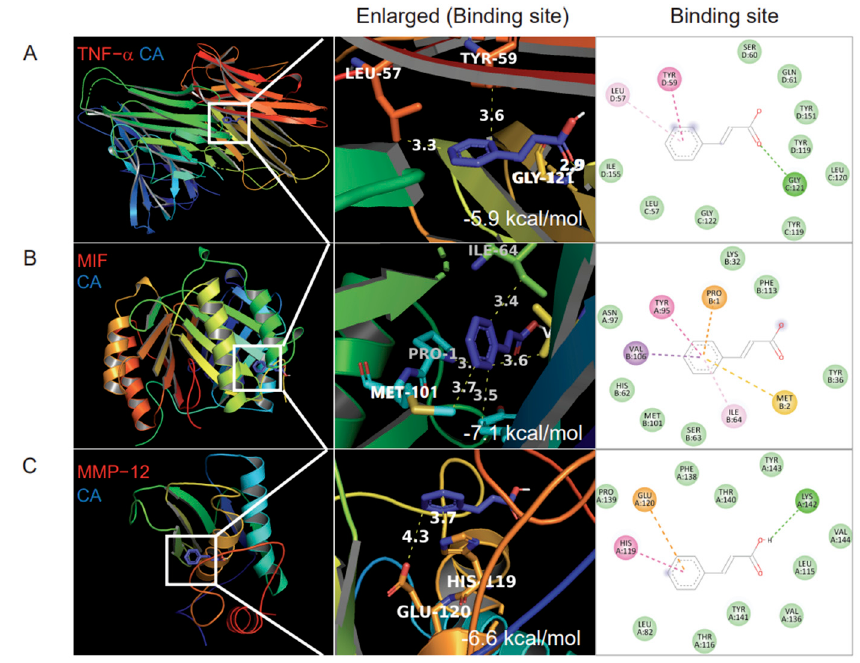
Figure 1. Molecular docking binding affinity of cinnamic acid (CA) for TNF − α , migration inhibitory factor (MIF), and elastase MMP − 12. ( A ) CA binding to TNF − α , ( B ) CA binding to MIF, ( C ) CA 12 binding to MMP. Three-dimensional structures of TNF- α (PDBID: 2AZ5), MIF (PDBID: 1GD0), and MMP-12 (PDBID: 1JIZ) were obtained from the PDB database. CA binding sites in the left panel are enlarged as indicated by white boxes. The binding score is displayed in the lower right corner of the second panel.